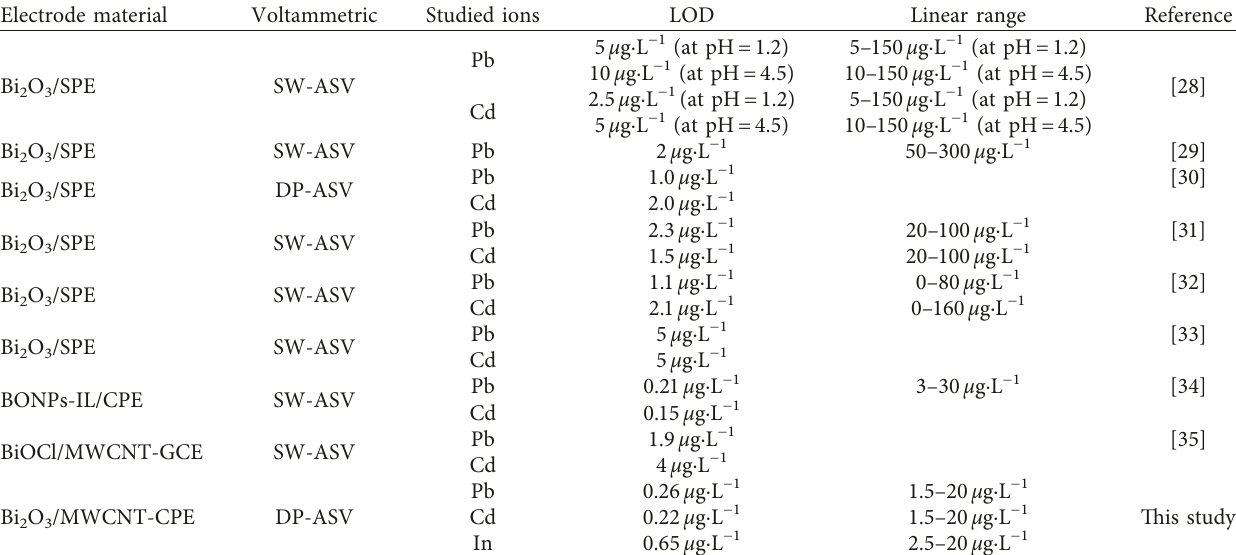
SPE: screen printed electrode; GCE: glassy carbon electrode; SW-ASV: square wave anodic stripping voltammetry; BONP: bismuth oxide nanoparticle; IL: ionic liquid; BiOCl: